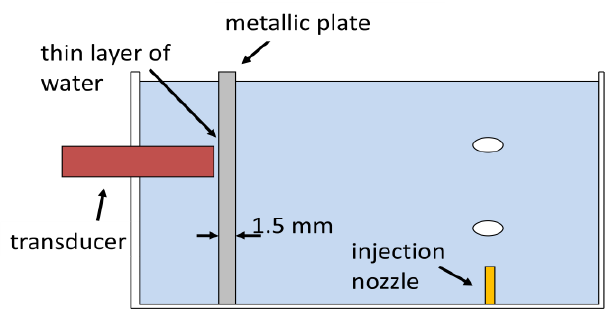
Figure 14. Cross-section diagram of metallic plate arrangement at the water tank.